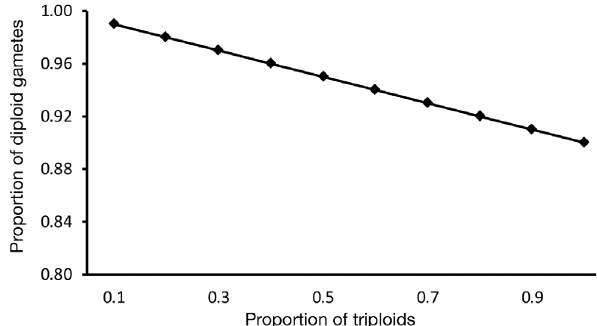
Fig. 4. Frequency of diploid zygotes expected in a popula- tion of Pacific oysters Crassostrea gigas (2 n = 20) with dif - ferent relative fecundities between males and females as a function of the proportion of